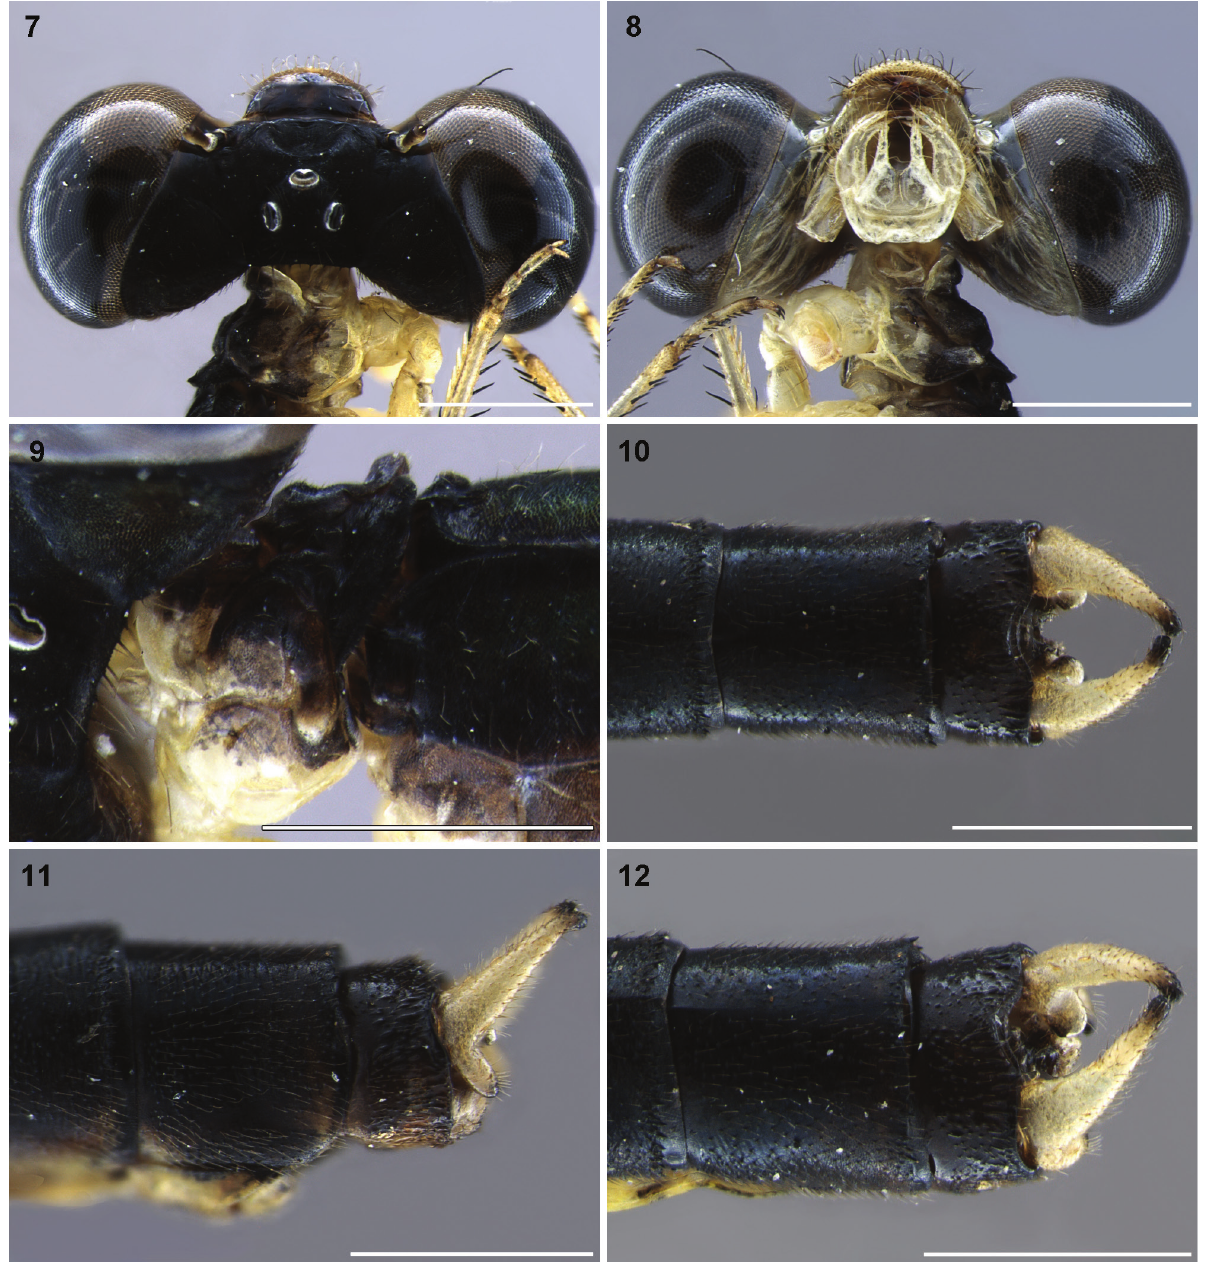
Figures 7–12. Forcepsioneura serrabonita sp. nov., holotype male (Brazil. BA: Camacan, DZRJ 0050): (7–8) head in dorsal (7) and ventral (8) views; (9) prothorax in dorsolateral view; (10–12) caudal appendages in dorsal (10), lateral (11) and dorsolateral (12) views. Scale bars = 1 mm.